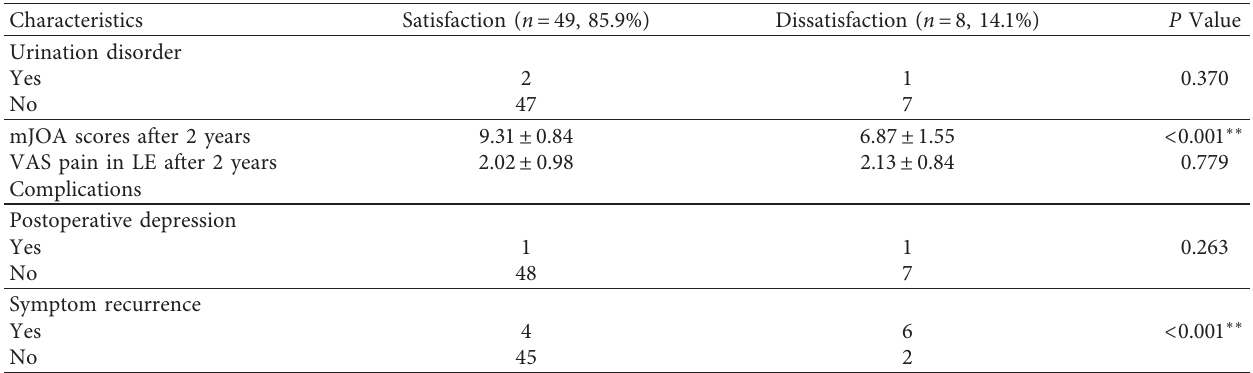
Table 7: The related risk factors of satisfied and dissatisfied patients at 2-year follow-up.